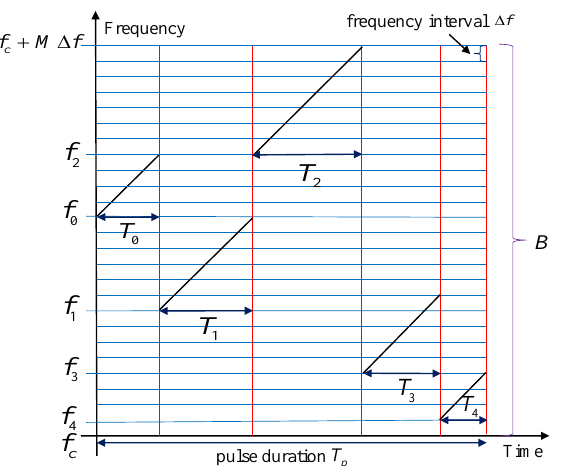
Figure 2. The proposed waveform consists of multiple FMCW chips with different widths and